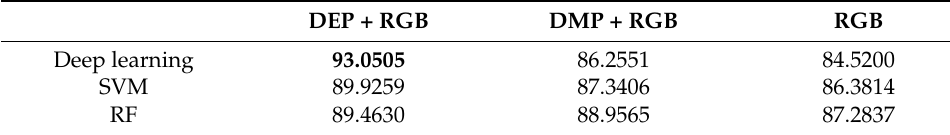
Table 4. Overall accuracy for Pleiades dataset.